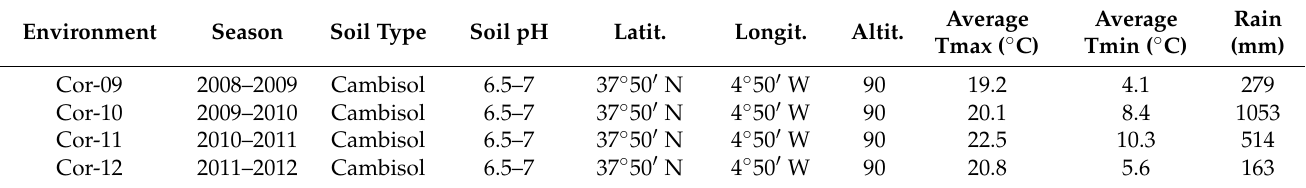
Table 2. Description of the environments (combination of location and season) of the trials for the multi-environment study. Climatic